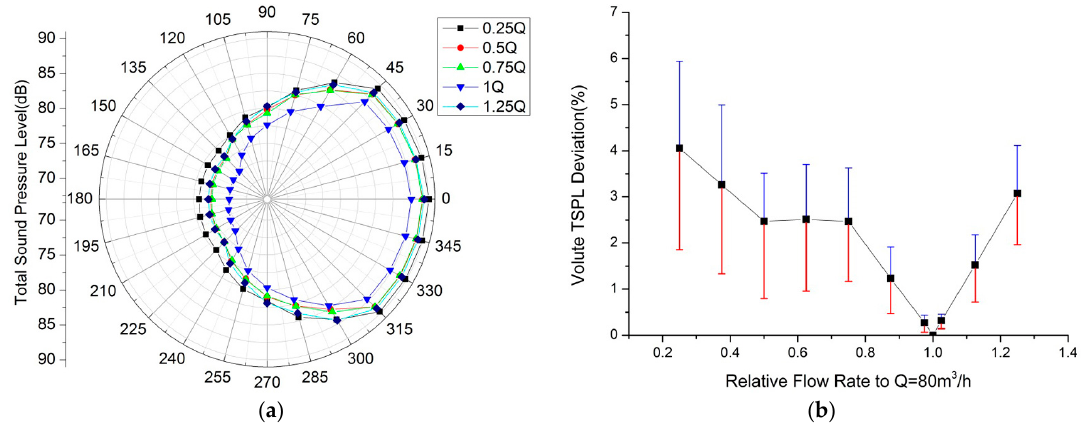
Figure 10. Volute radiation noise. ( a ) Total sound pressure level of directivity field from the volute; and ( b ) the relationship of TSPL deviation vs. the flow rate.